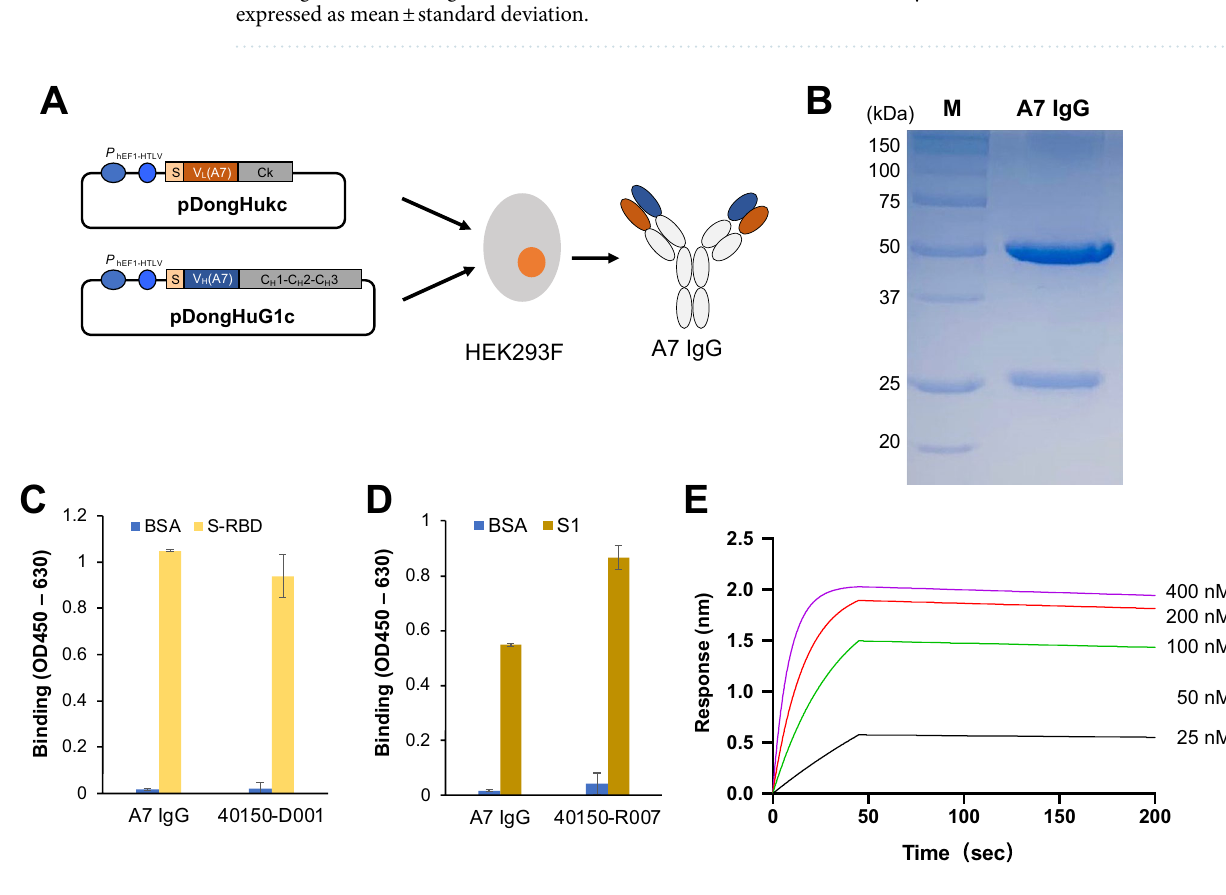
Figure 5. Expression and characterization of A7 IgG. ( A ) The scheme for expression of A7 IgG in the mammalian cells, HEK293F; ( B ) SDS-PAGE analysis of purified A7 IgG; ( C , D ) Antigen-binding ELISA of A7 and positive control IgGs; and ( E ) BLI sensorgram of A7 IgG. In ( C , D ), each protein (2 µg/mL) coated on the microplate well was reacted with 5 µg/mL A7 IgG. n = 3; Data have been expressed as mean ± standard deviation. Original gel image is presented in Supplementary Fig.